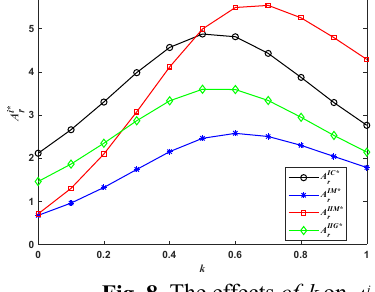
Fig. 7. The effects of k on i e . Fig. 8. The effects of k on i